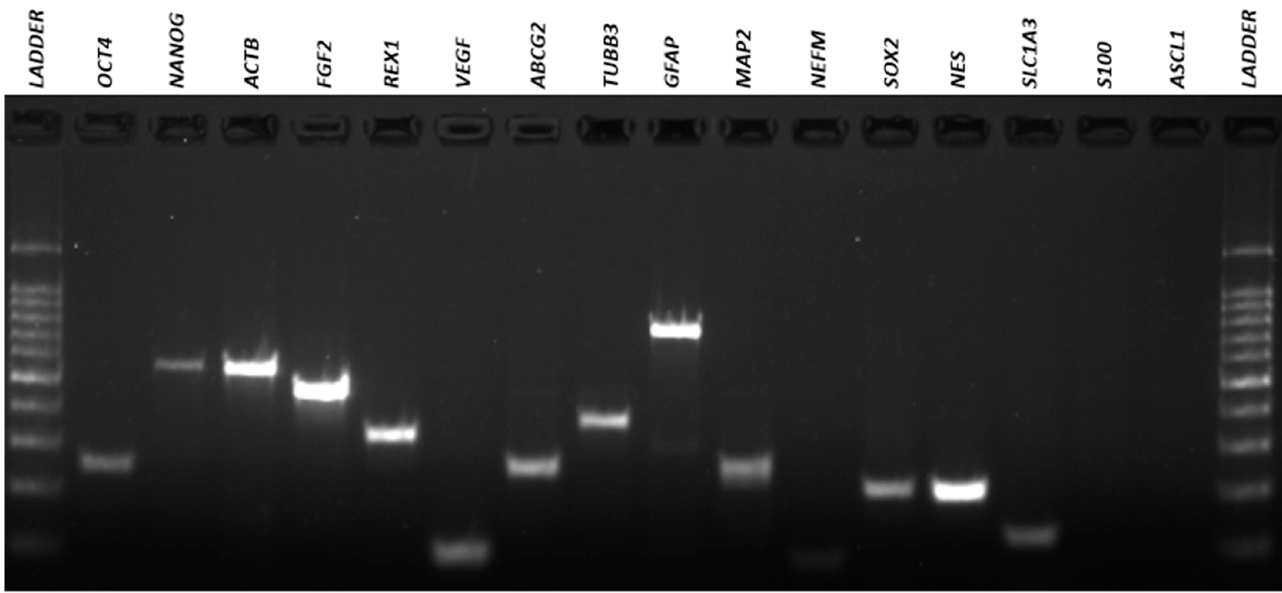
Figure 7. ADMSCs electrophoresis gel. RT-PCR for amplification of OCT4 (292bp), NANOG (578 bp), ACTB (564 bp), FGF2 (482 bp), REX1 (344 bp), VEGF (107 bp), ABCG2 (270 bp), TUBB3 (385 bp), GFAP (789 bp), MAP2 (241 bp), NEFM (98 bp), SOX2 (224 bp), NES (220 bp), SLC1A3 (136 bp), S100 (261 bp) and ASCL1 (122 bp) genes in ADMSCs. ADMSCs, adipose-derived mesenchymal stem cells.